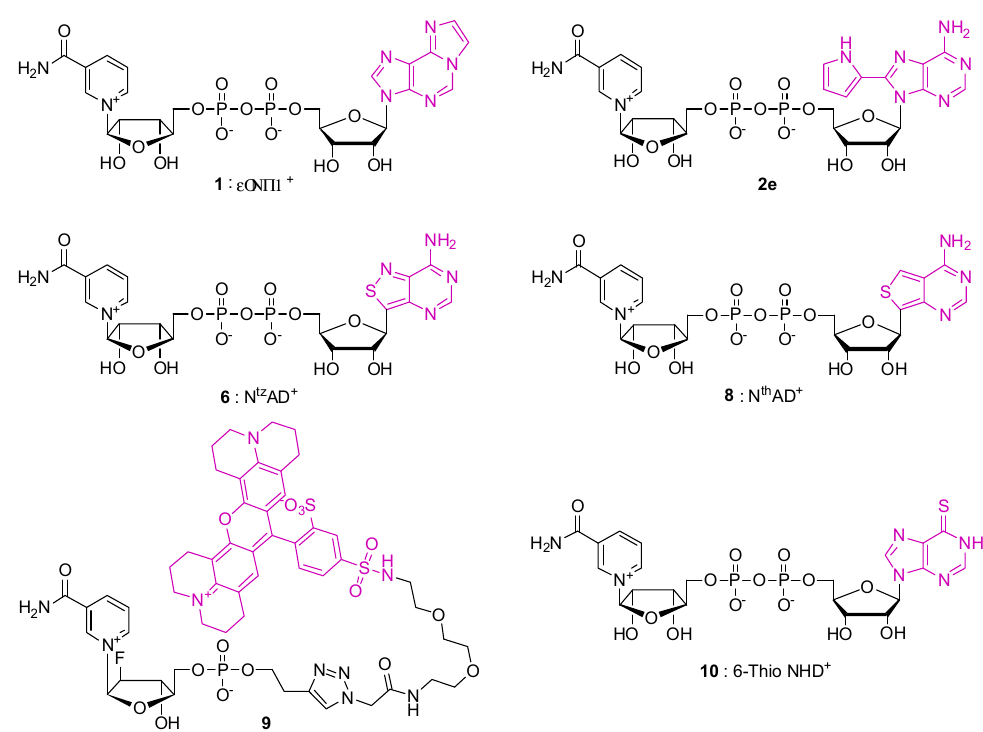
Figure 2. Representative NAD + analogs developed as fluorescent probes for NAD-consuming enzymes. The fluorophore is marked in purple. For emissive properties, see Table 1.